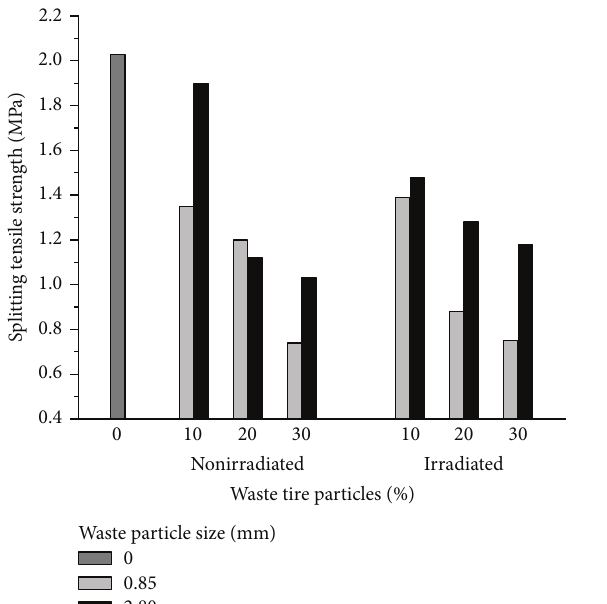
Figure 3: Splitting tensile strength of concrete with waste tire particles.